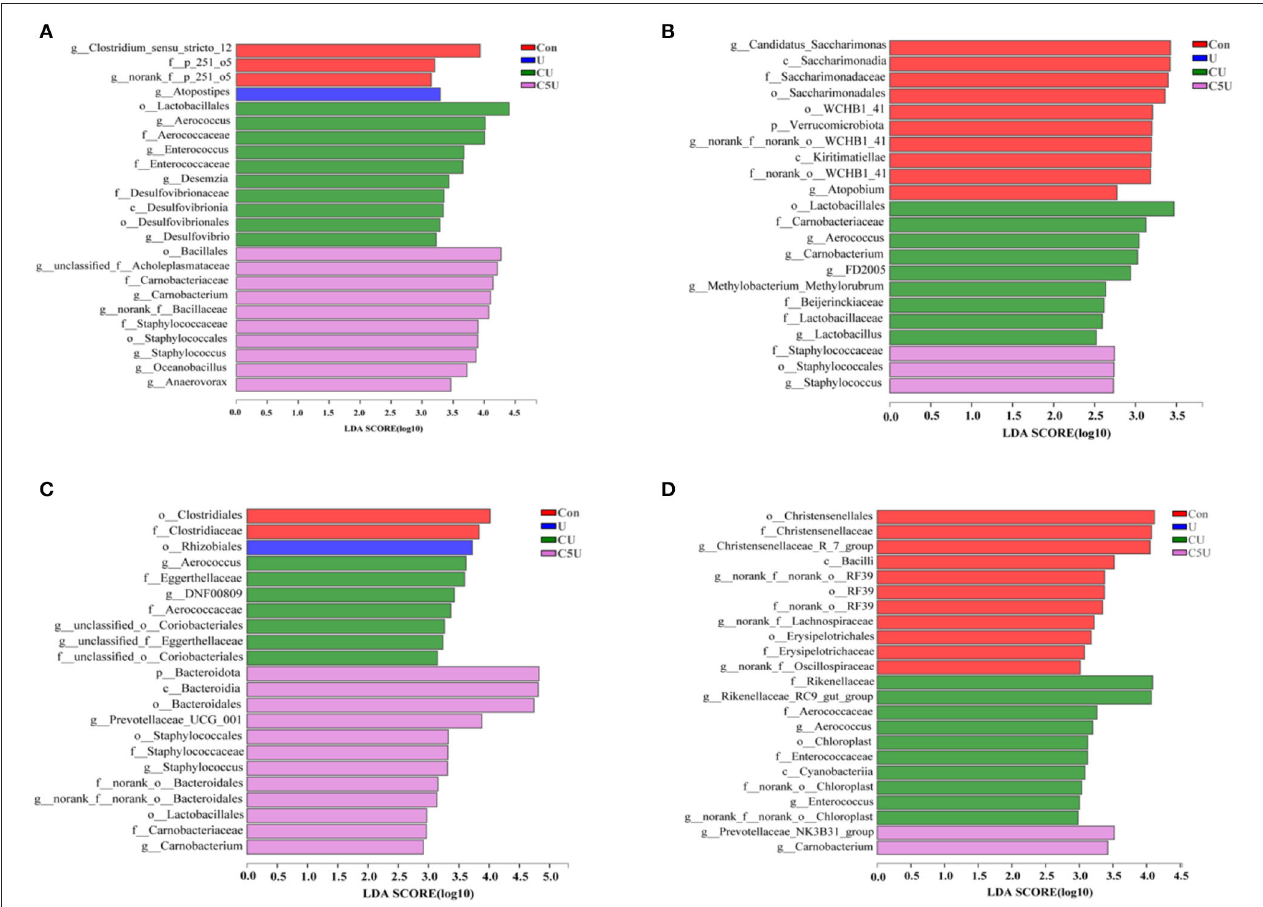
FIGURE 5 | LEfSe analyses of the bacterial community shift to RS after 0.5h (A) , 4h (B) , 12h (C) , and 24h (D) within the rumen. Con, without additive control; U, 5% urea; CU, 9% CSL + 2.5% urea; C5U, 9% CSL + 5%